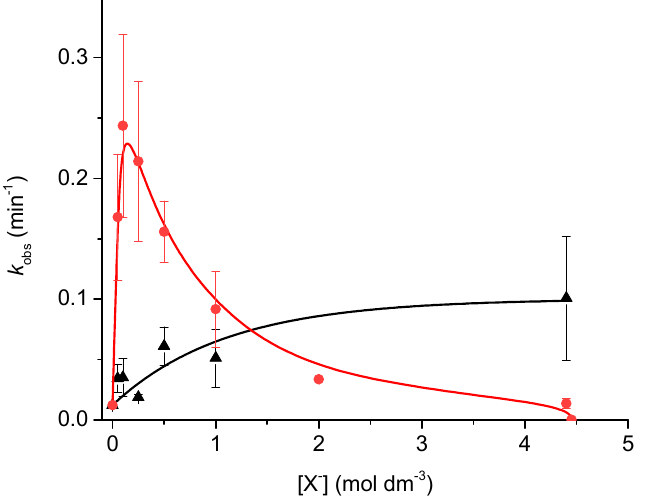
Figure 5. k obs for the homocoupling reaction of 150 μ M 1 in water with pH 9 borate buffer (10 mM) and catalyst Pd ‐ PPy ‐ PS (1.8 μ M Pd) over the course of 7 h at 70 °C at varying [Cl − ] ( ▲ ) and [Br − ] ( ● ). Lines are drawn to guide the eye, error bars represent standard deviations.